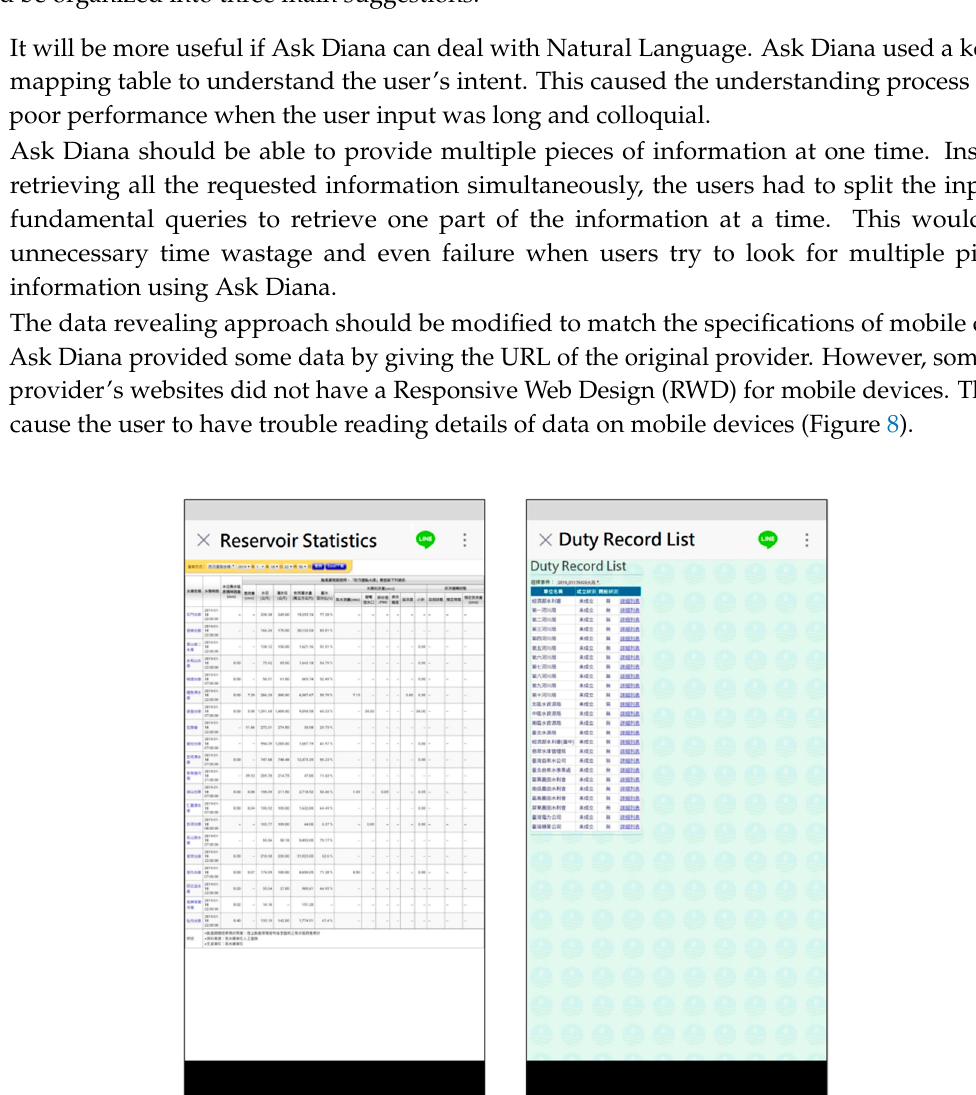
Table 4. The usability test results.